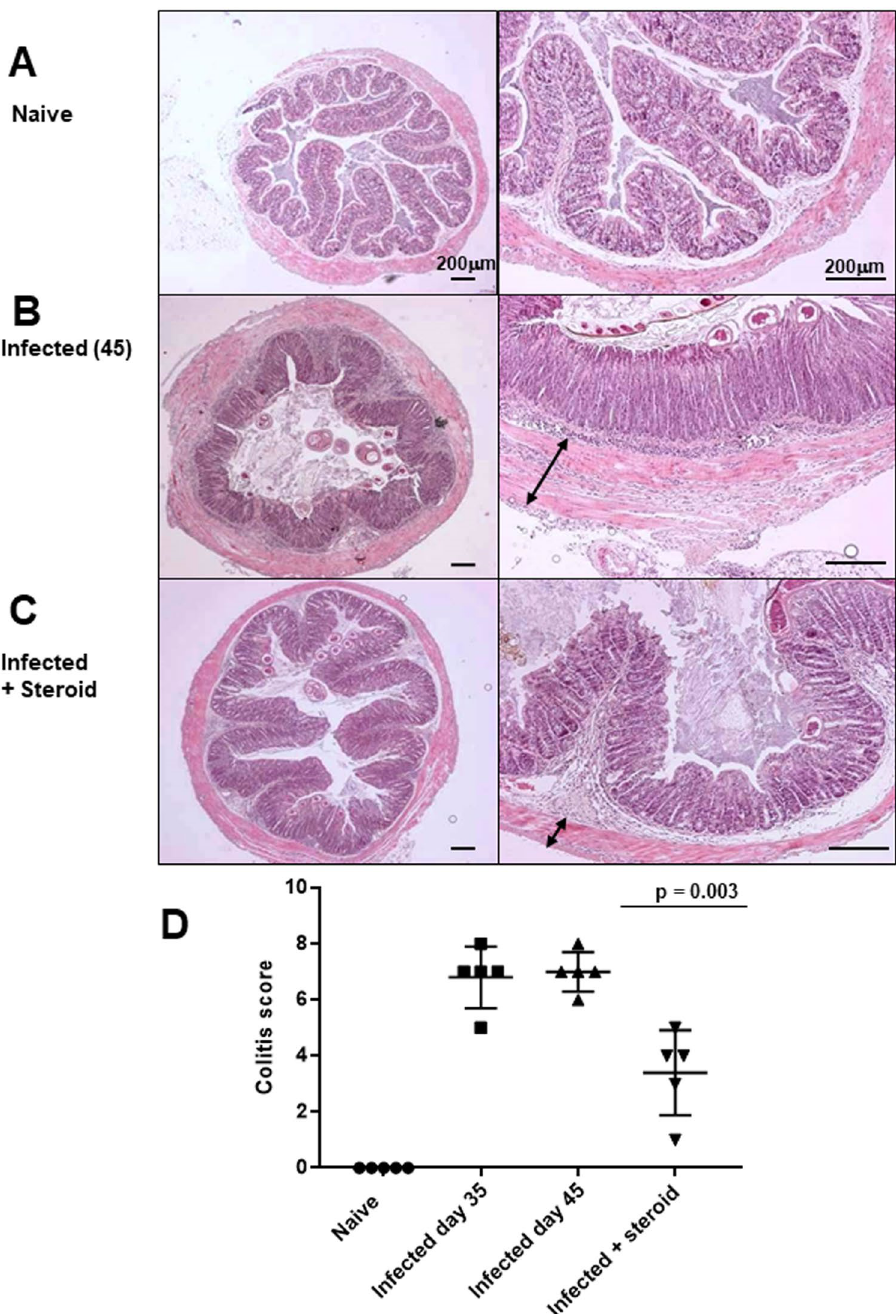
Figure 2. Hydrocortisone intervention significantly improves histological colitis score in T . muris infected mice at day 45 p.i. (H&E, scale bar = 200 μ m). ( A ) Normal colonic tissue in naïve mice. ( B,C ) Luminal and mucosal helminths and transmural colonic inflammatory changes were seen post T . muris infection in AKR/J mice. A reduction of muscle layer oedema, (double headed arrows) accompanied by a reduction in submucosal oedema and crypt hyperplasia was identified following steroid treatment of infected mice ( C ). ( D ) The histological assessment of mucosal architecture, ulceration, crypt abscesses, goblet cell depletion, cellular infiltration and tissue oedema was quantified. A significant reduction in colitis severity was seen following steroid treatment. Data represented as mean + / − SD, representative of two independent experiments, n = 5 per